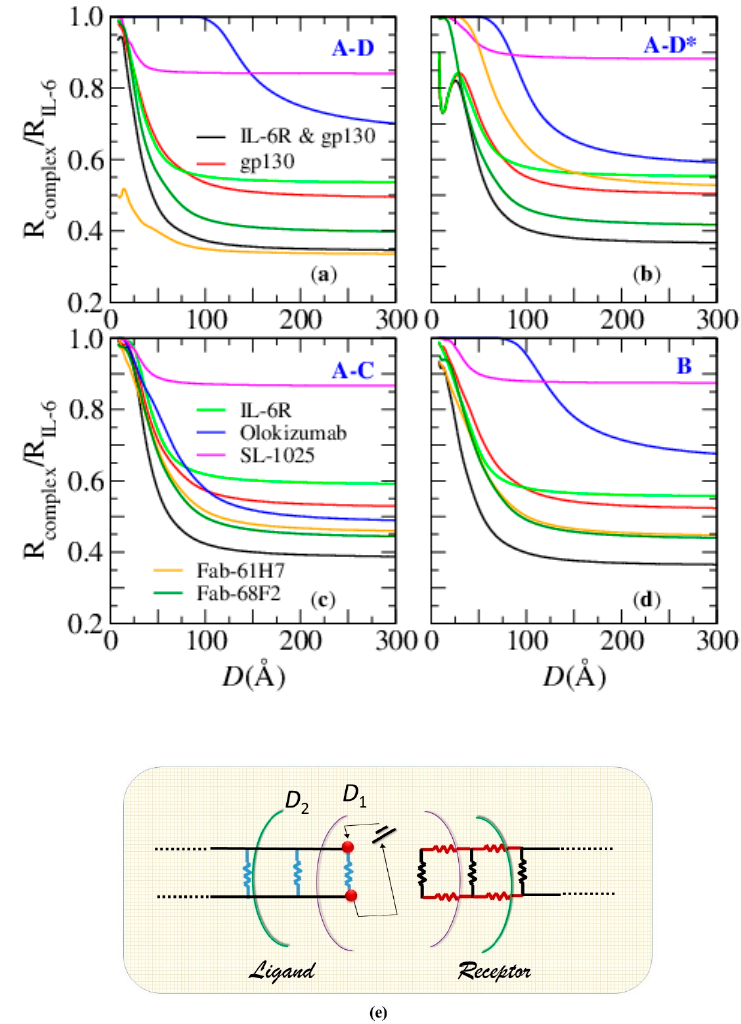
Figure 6. Relative resistance of IL-6 complexed with several receptors. Ideal electrical contacts are: ( a ) on helices A–D close to N-terminus, input / output GLU10 / MET171; ( b ) on helices A–D in the opposite orientation (A–D*), input / output THR30 / ASN142; ( c ) on helices A–C, input / output THR30 / ALA117; ( d ) on helix B, input / output ASN66 / SER95; ( e ) the ladder resistance network equivalent of the